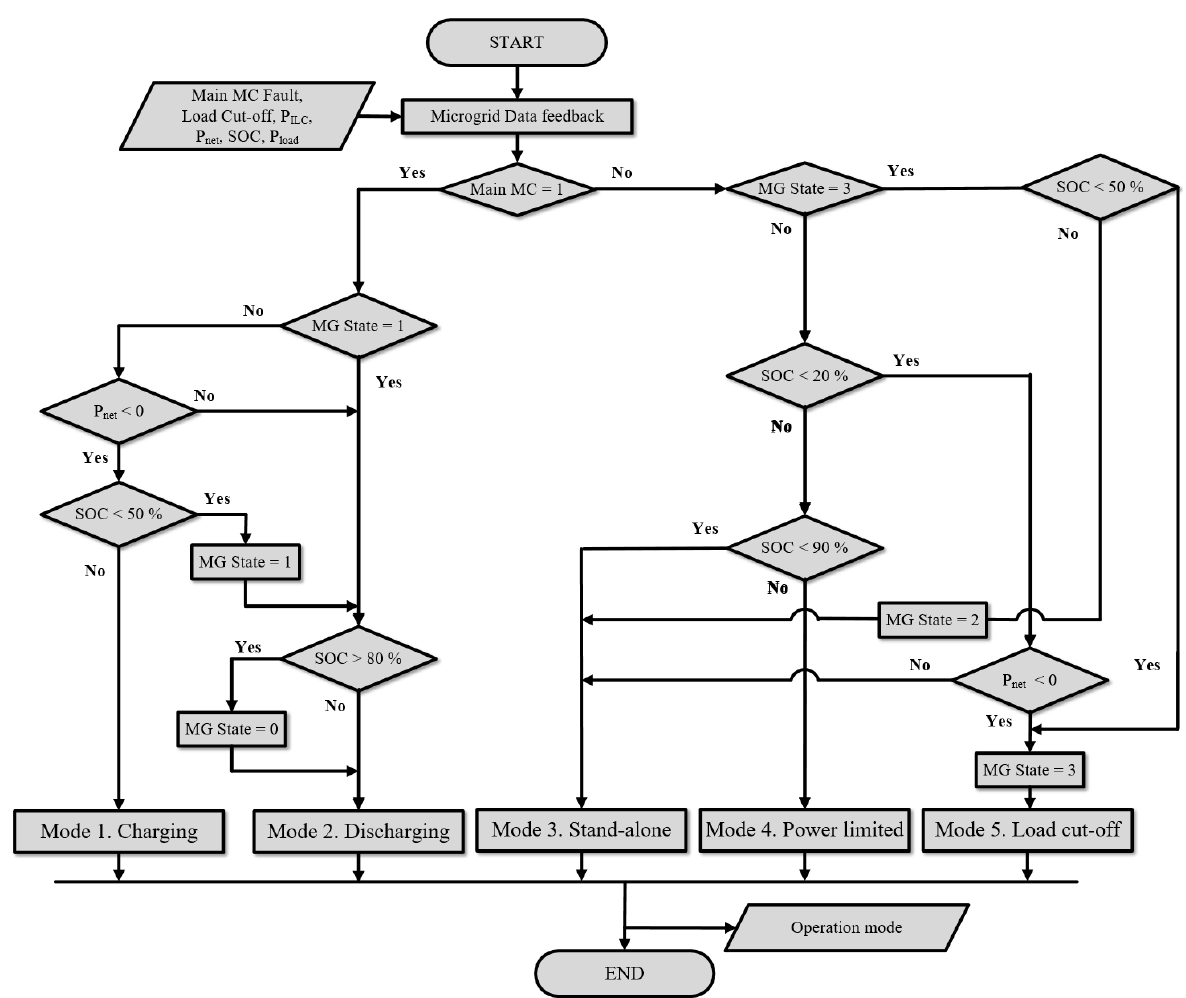
Figure 6. Operation algorithm of hybrid AC/DC microgrid.